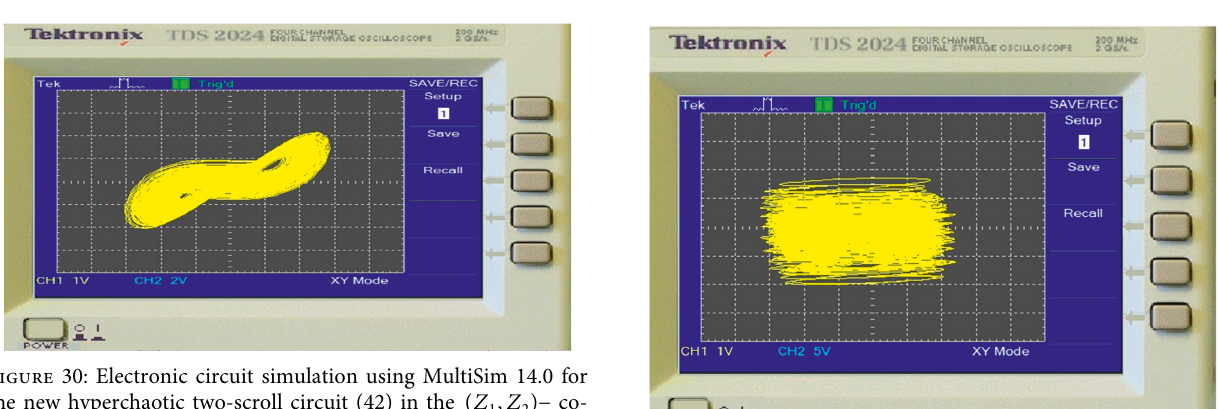
, Z )− co- 1 2 Figure 33: Electronic circuit simulation using MultiSim 14.0 for the new hyperchaotic two-scroll circuit (42) in the ( Z ordinate